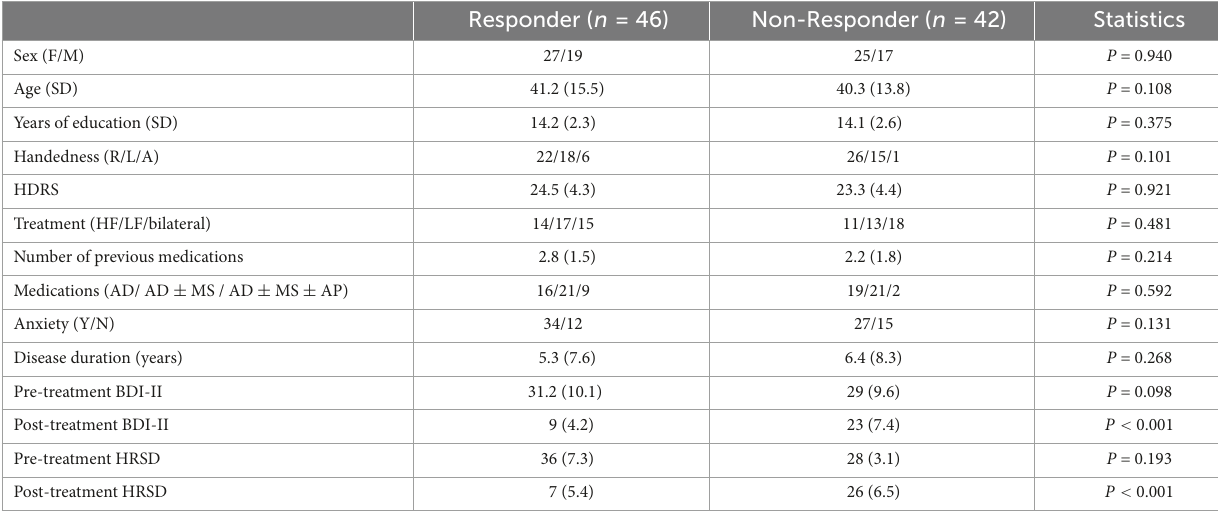
TABLE 1 Clinical and demographic